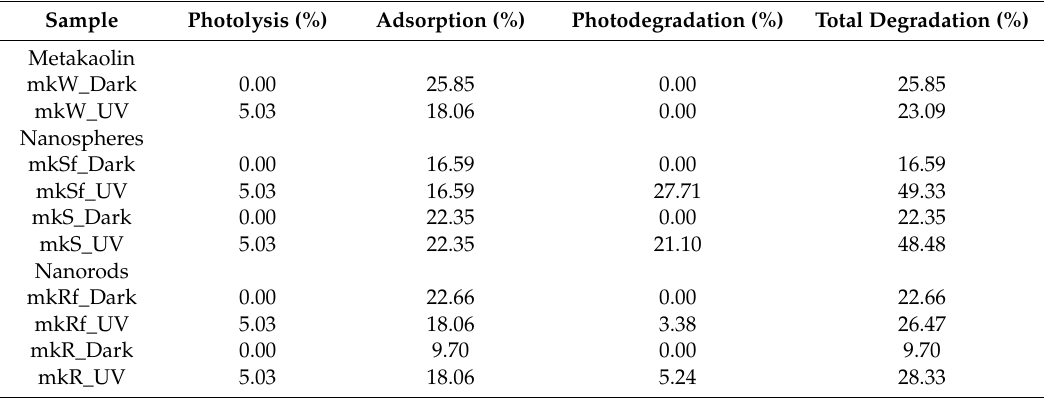
Table 1. E ff ects in the photodegradation process in metallurgical slag-based pastes.